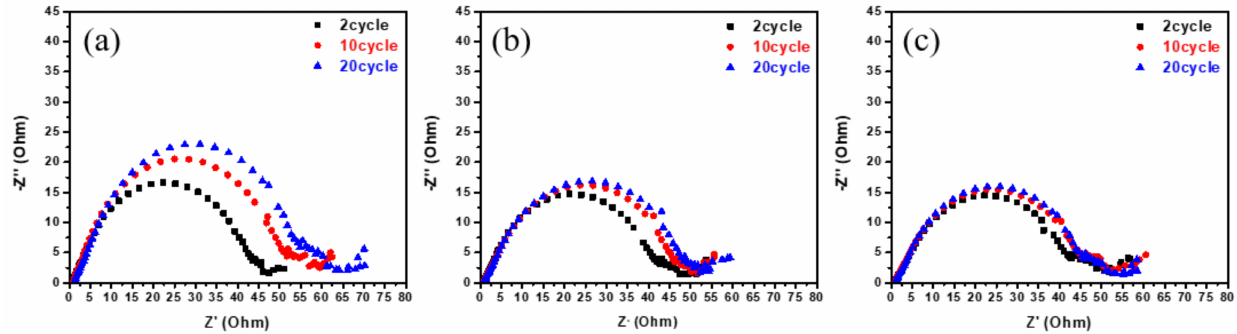
Figure 9. Nyquist plots of ( a ) HSC, ( b ) HSBC and ( c ) HSBGC